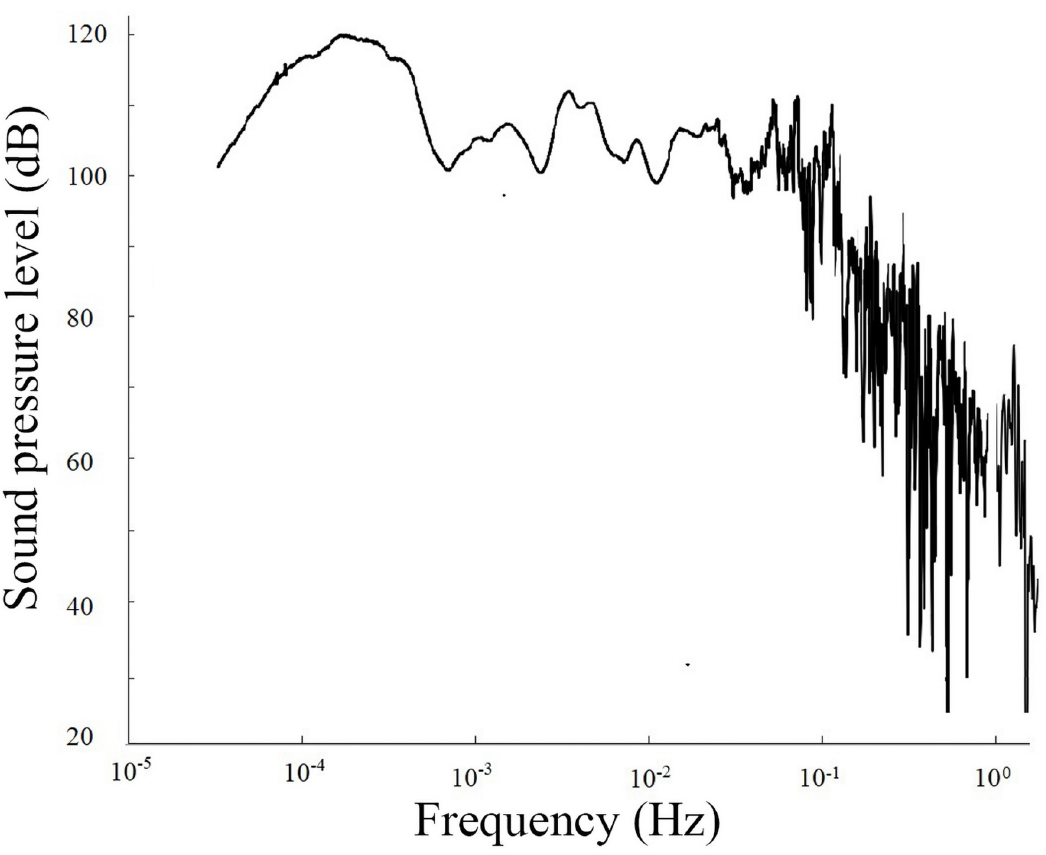
Fig 8. Frequency of anomalous infrasound signals on April 11,